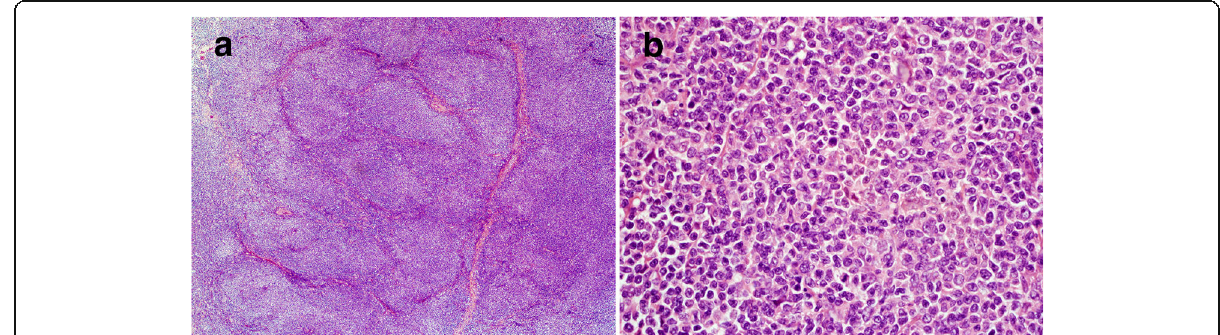
Fig. 1 Diagnostic low grade follicular lymphoma. Excisional biopsy reveals a nodular lymphoid proliferation of small lymphocytes with elongated